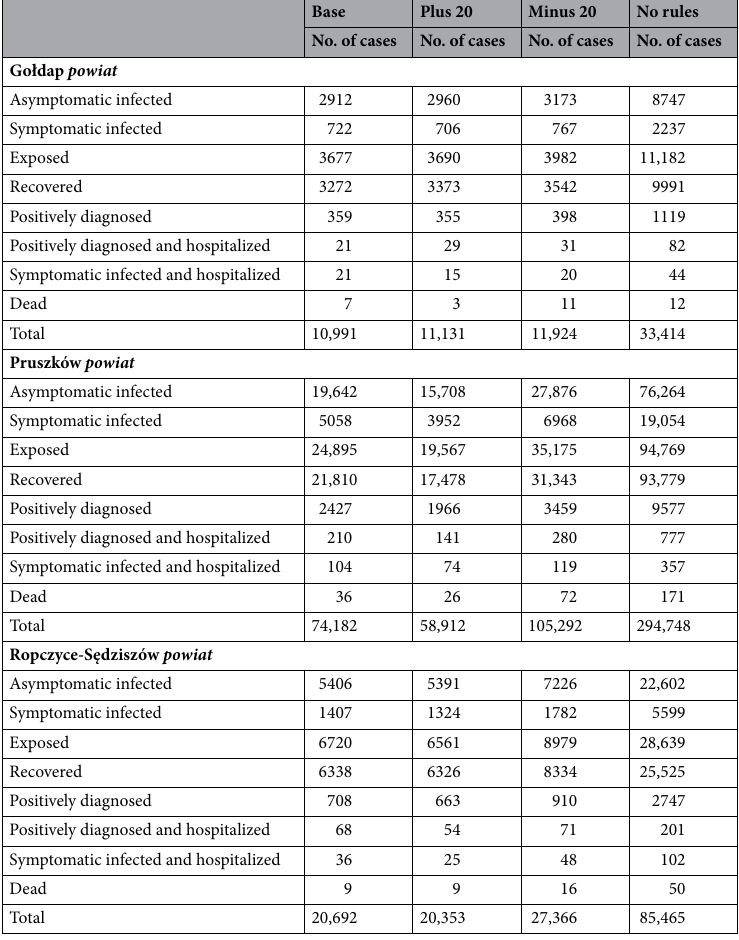
Table 3. Numerical results obtained in the multiagent model for the tested